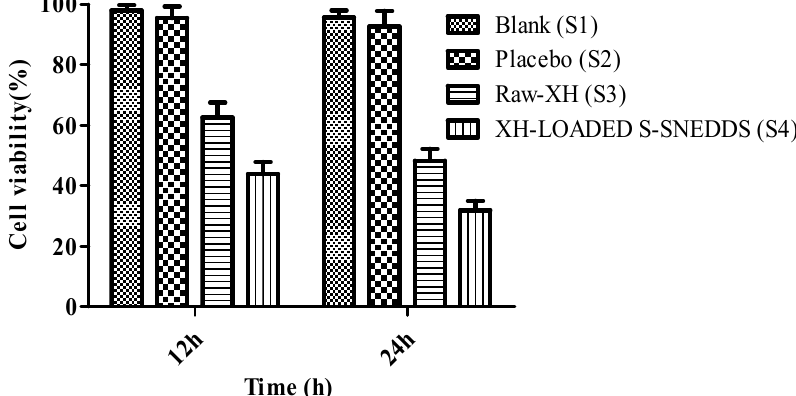
Figure 7. Results of cell viability (%) for blank, placebo, raw-XH and XH-loaded S-SNEDDS [number of replicates (n) =